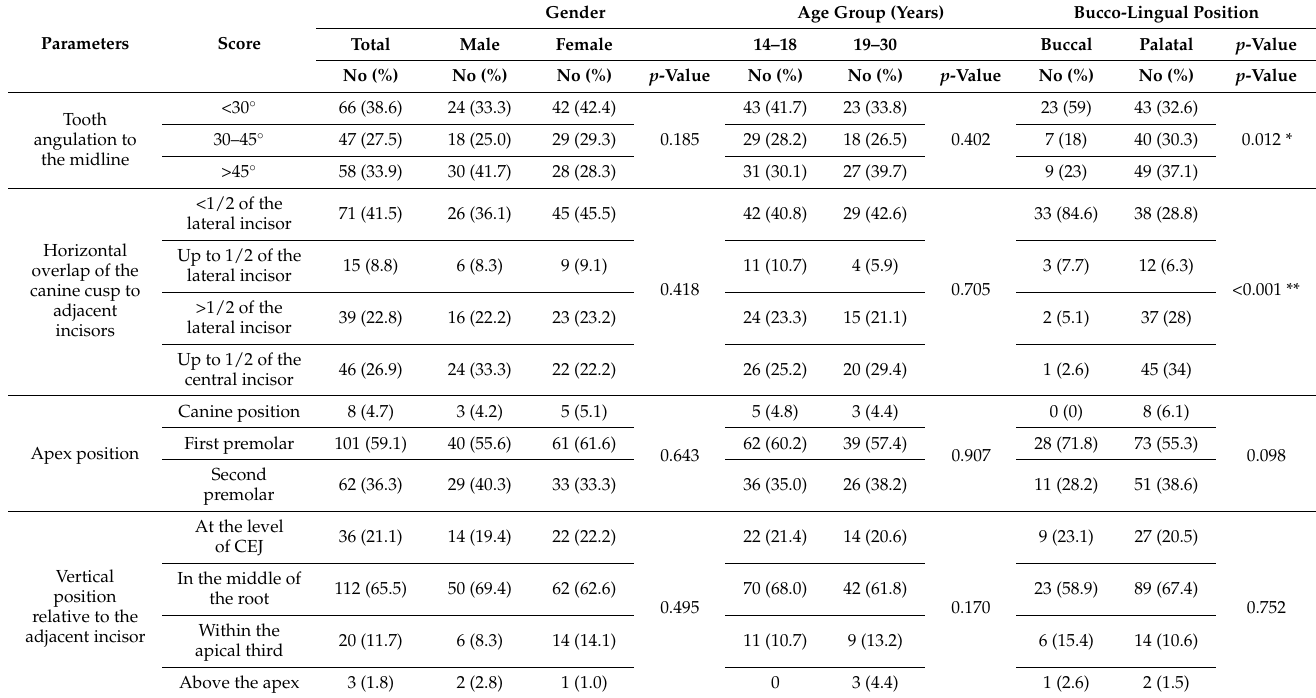
Table 3. Associations between the severity of canine impaction, gender, age group, and bucco-palatal impaction using Pearson’s chi-square test of independence (N = 171).